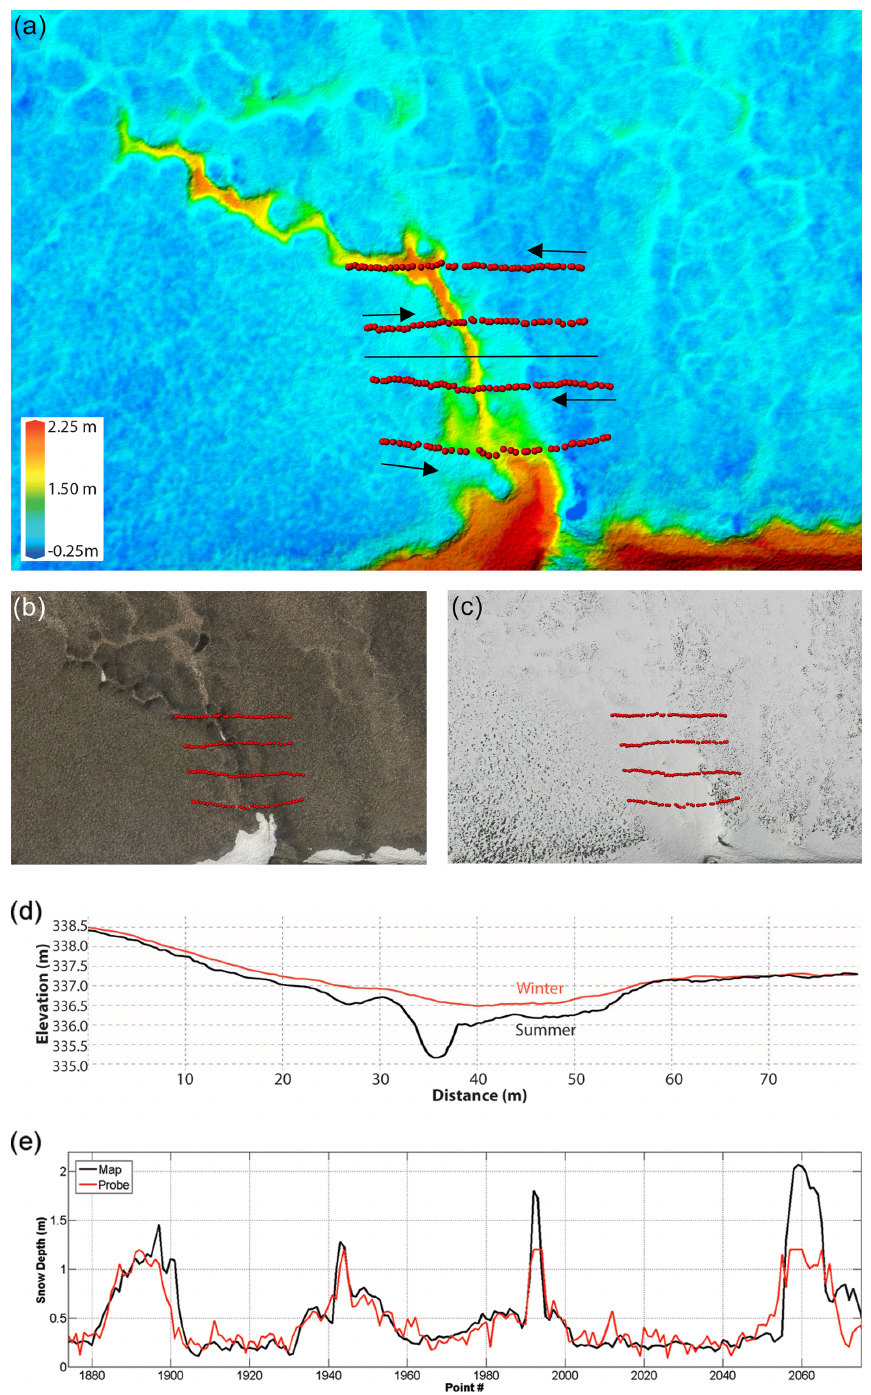
Figure 6. (a–c) Drifting fills gullies with snow in the Hulahula region (inset at right in Fig. 5). We probed across this gully in 4 transects (red dots) to test our technique over a wide range of snow depths. The snow and ground surface profiles (summer and winter elevations) shown in (d) are 80m long and their location is shown in (a) as a black line. The profiles show that the main gully, here about 1.5m deep, was completely filled with snow, but snow depths were near zero to the right as confirmed by bare ground showing in the orthoimage (b) . As in Fig. 4, we have unfolded the 4 probe transects into a continuous line (e) , which again shows a remarkable agreement between the ground probing and the photogrammetric map. The map-derived snow depths reproduced all of the features revealed by the probes, with a standard deviation of 20cm, despite the several confounding influences described in the text (e.g., footprints, vegetation, 1 month difference between measurements). The probes have a maximum reach of 1.2m and so did not penetrate through the deeper parts of the